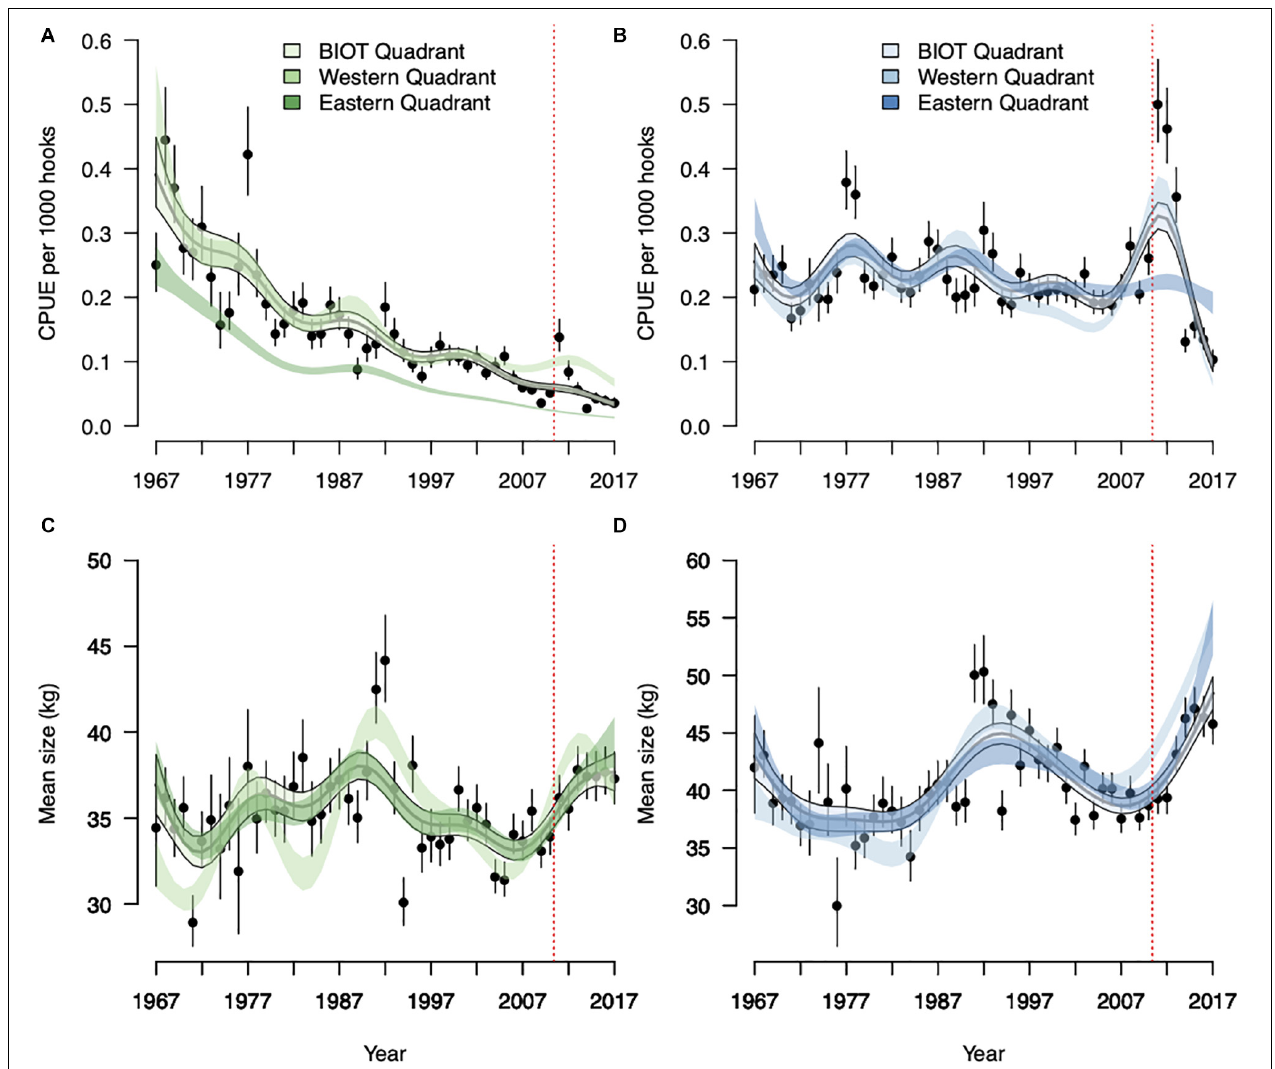
FIGURE 4 | Annual trends in catch per unit effort (CPUE; tons per thousand hooks) and the mean size (in kilograms) of yellowfin tuna [ Thunnus albacares ; (A,C) , respectively] and bigeye tuna [ Thunnus obesus ; (B,D) , respectively] caught by longline vessels within the British Indian Ocean Territory (BIOT), eastern and western quadrant (each relating to nine Indian Ocean Tuna Commission reporting grid cells). The solid lines depict predicted CPUE from BIOT quadrant models with a continuous year effect. Vertical dashed red line denotes the BIOT marine protected area’s establishment in 2010. The shaded polygons represent the 95% confidence intervals, with the BIOT quadrant polygons outlined. Points indicate estimates from BIOT quadrant models only, with year treated as a factor variable and error bars representing ± two standard errors. Predictions for the eastern and western quadrants from models with year treated as a factor are omitted for